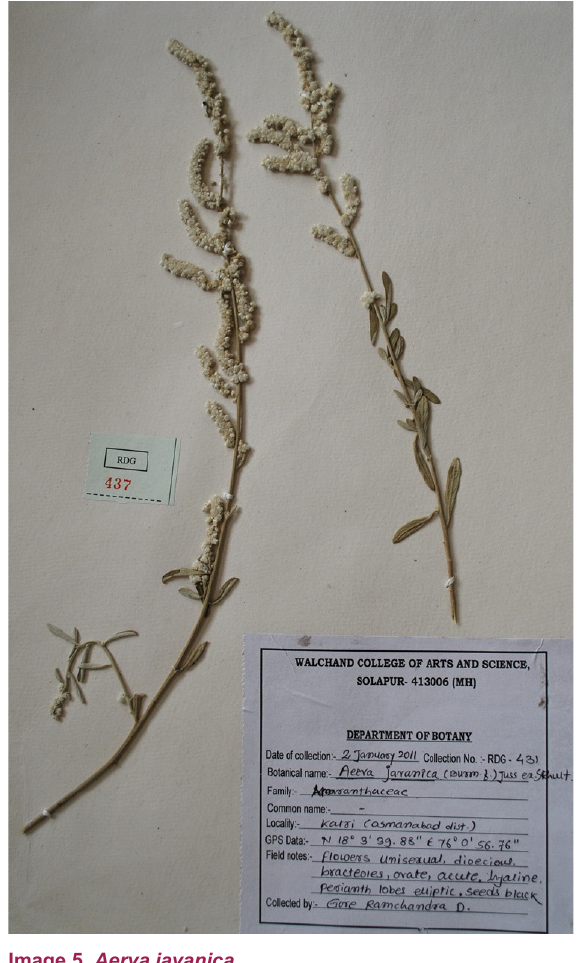
Image 5. Aerva javanica